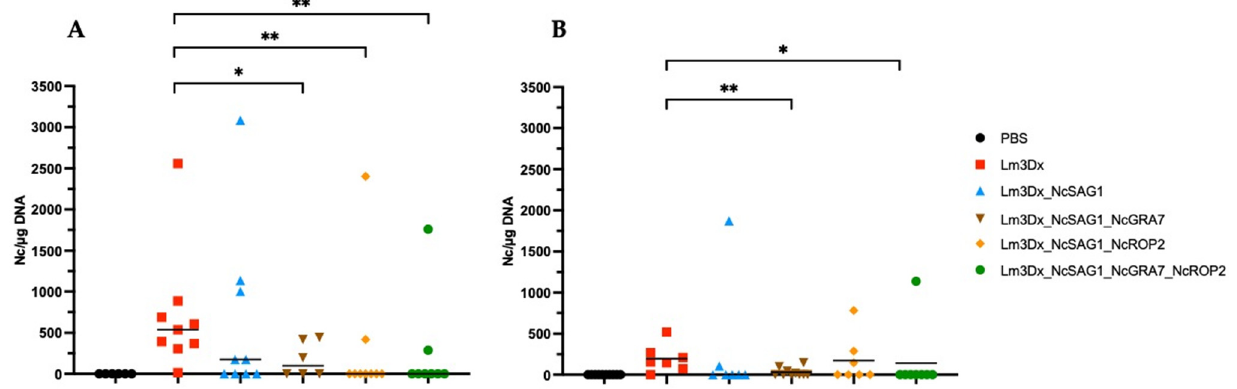
Figure 3. Evaluation of cerebral parasite load in dams ( A ) and non-pregnant mice ( B ). Directly after euthanasia, brain tissues were collected aseptically and further processed to quantify N. caninum DNA (Nc/µg DNA) by RT-qPCR. Values are arranged in scatter plots. Dams that were immunized thrice either with the double mutants or the triple mutant vaccine showed statistically significant differences compared to the positive control group, which was inoculated thrice with the empty vector Lm3Dx ( ** p < 0.0084, * p < 0.0356; Mann–Whitney U test). In non-pregnant mice, statistically